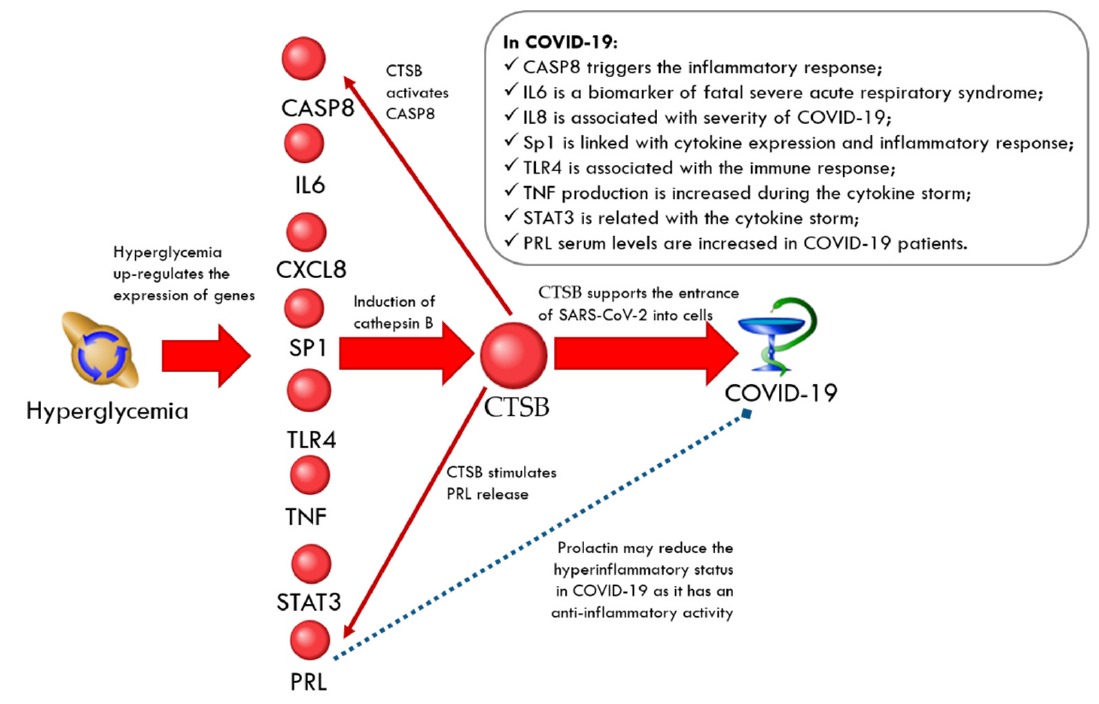
Figure 7. The regulation loop in the CTSB-related network involves CASP8, IL6, CXCL8, SP1, TLR4, TNF, STAT3, and PRL. The red arrows correspond to the up-regulation and the blue arrow corresponds to the down-regulation.